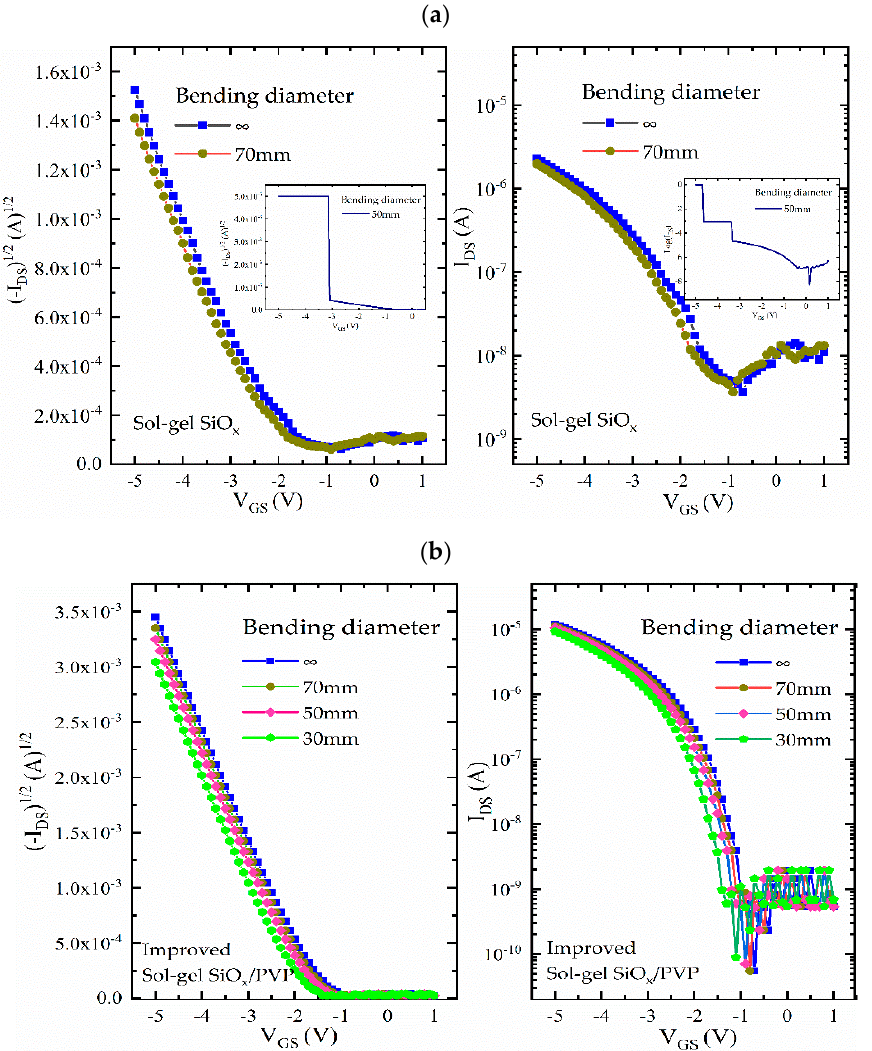
Figure 5. The electrical performance of the flexible OTFTs based on ( a ) sol–gel SiO x , ( b ) improved sol–gel SiO x / PVP dielectric with a PI substrate during a stretchable test, applying bending diameter at 70 mm, 50 mm or 30 mm.